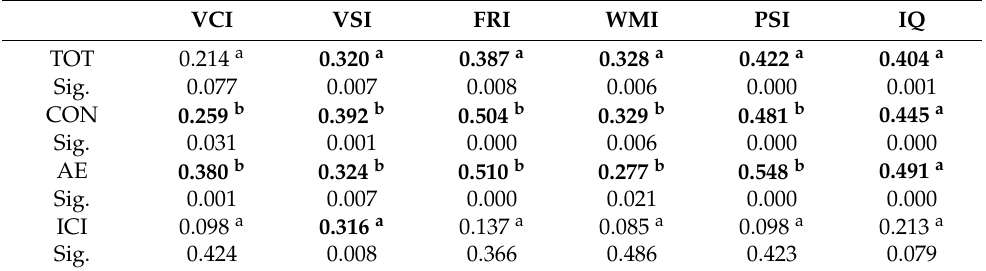
Table 6. Correlations between intellectual and attention skills in the total sample of preterm